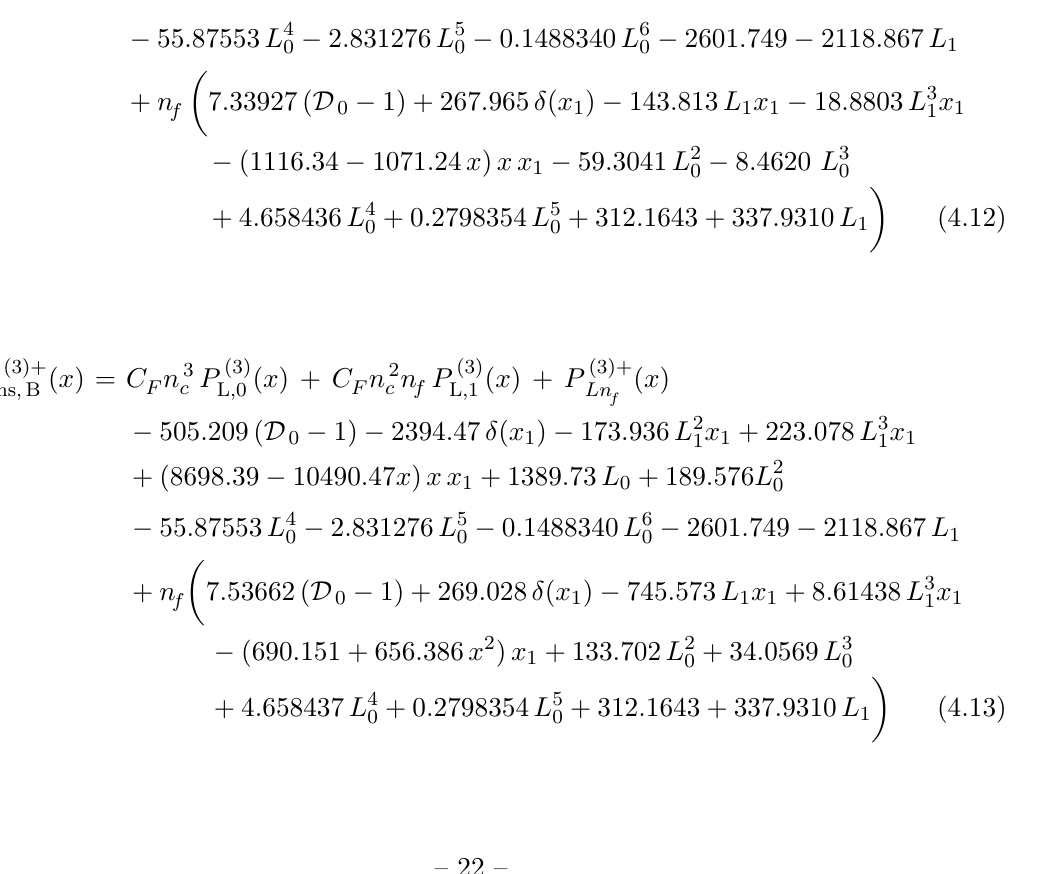
Figure 5 . About 90 trial functions for the n large- n c part of splitting function P (3)+ ns ( x ), multiplied by x 0 : 4 (1 two functions chosen to represent the remaining uncertainty are denoted by A and B and shown by solid (blue)